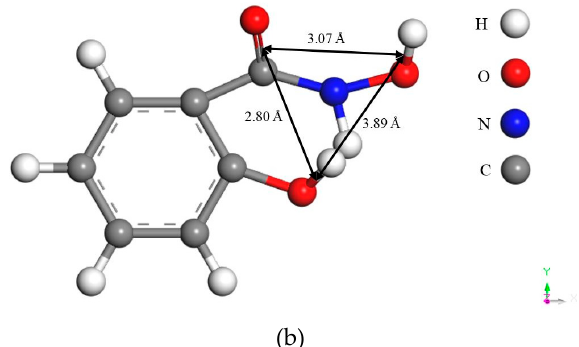
Figure 2. Molecular structures of the ( a ) salicylaldoxime and ( b ) salicylhydroxamic acid.